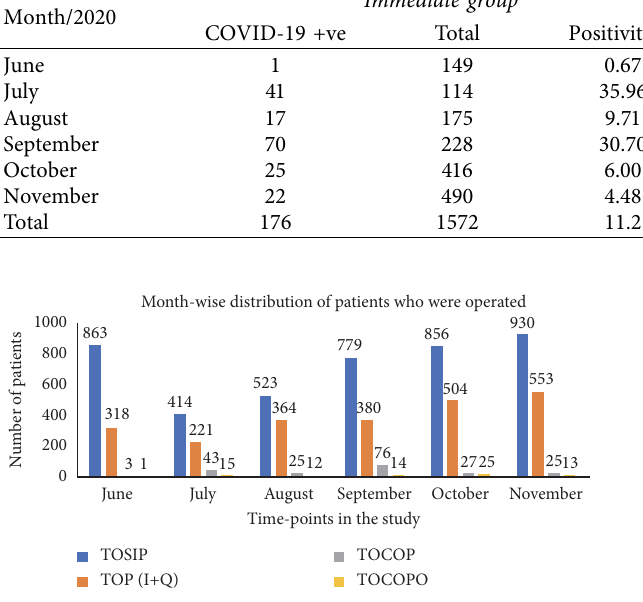
Figure 2: Comparison of various categories of patients operated during the study period. TOSIP � total surgical inpatients; TOP (+Q) � total operated patients; TOCOP � total COVID-19 positive patients; TOCOPO � total operated COVID-19 positive patients.